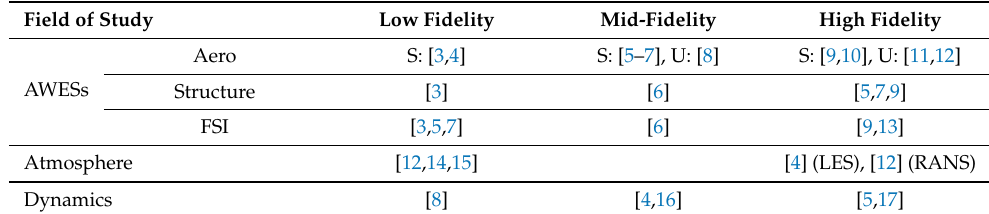
Table 1. Matrix of state-of-the-art AWE models (S, steady; U, unsteady). Field of Study Low